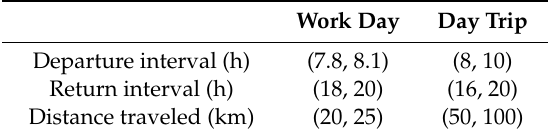
Table 1. Time intervals and distance traveled in work days and day